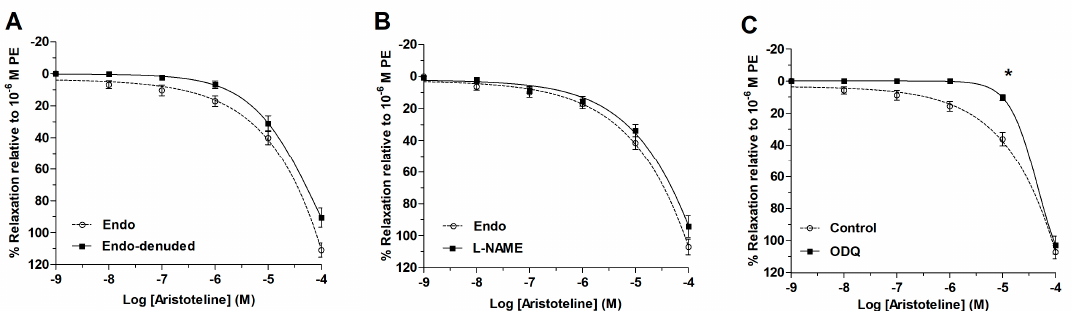
Figure 2. ARI directly causes relaxation on vascular smooth muscle of aorta. Vasodilatation response induced by ARI (1 nM to 100 µ M) after the addition of phenylephrine (PE) (1 µ M) is shown in intact aortic rings (endo or control) and denuded aorta (endo-denuded) ( A ), preincubate with L-NAME (100 µ M) ( B ) or with 1 H -(1,2,4)oxadiazolo[4,3- a ]quinoxalin-1-one (ODQ) (1 µ M) ( C ). Values are